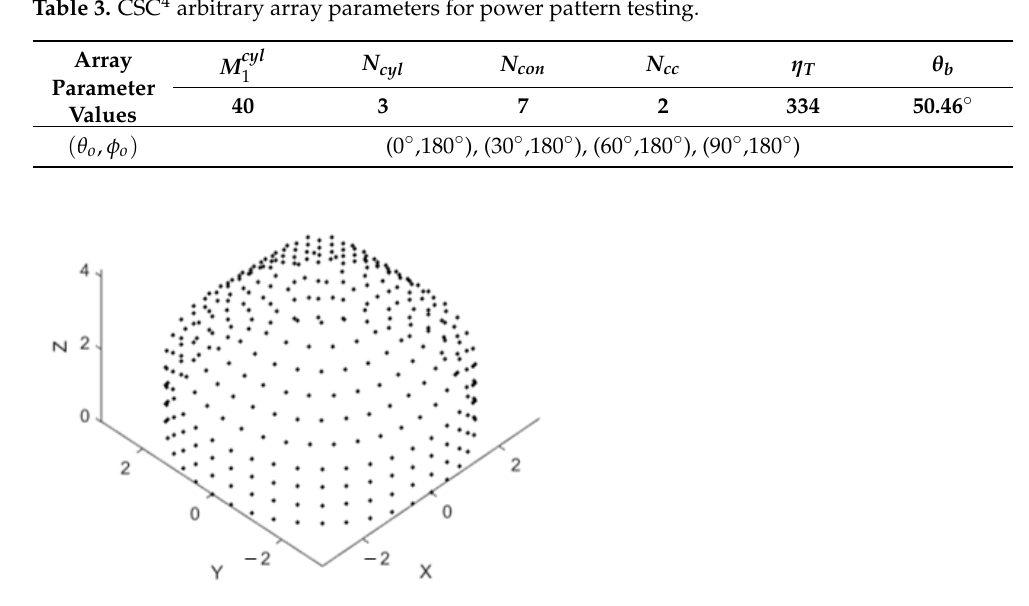
Table 3. CSC 4 arbitrary array parameters for power pattern testing.